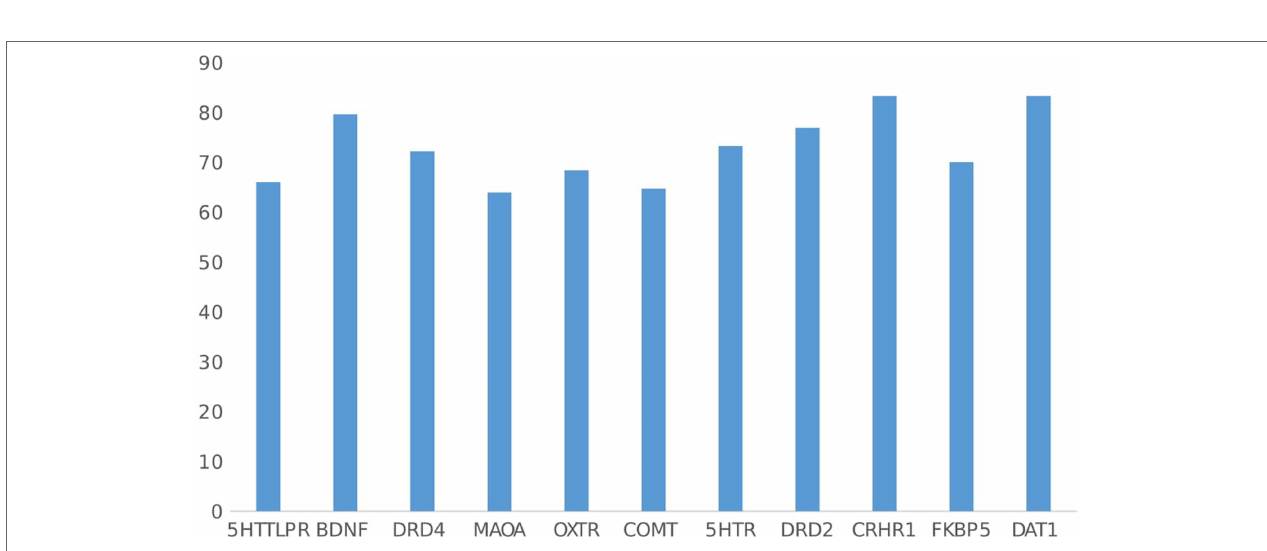
FiGURe 7 | Sample age by